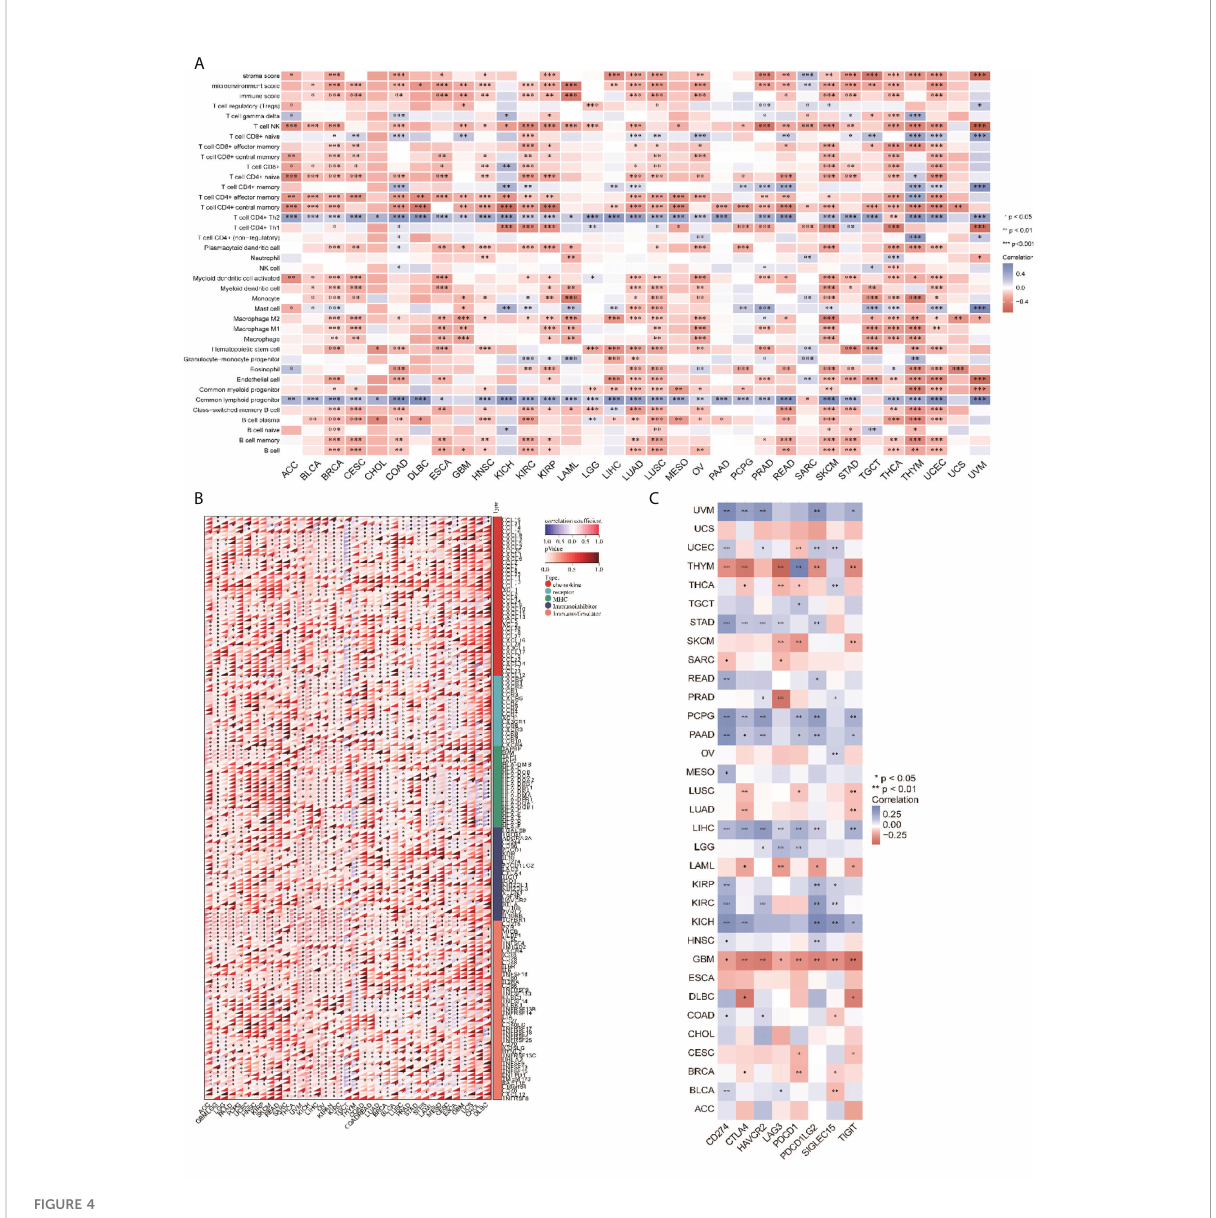
FIGURE 4 CCT2 expression and cancer immune correlation. (A) CCT2 expression levels in different tumors correlated with the in fi ltration levels of 26 immune-related cells. (B) CCT2 expression levels in different tumors correlated with immune genes. (C) CCT2 expression levels in different tumors correlated with immune